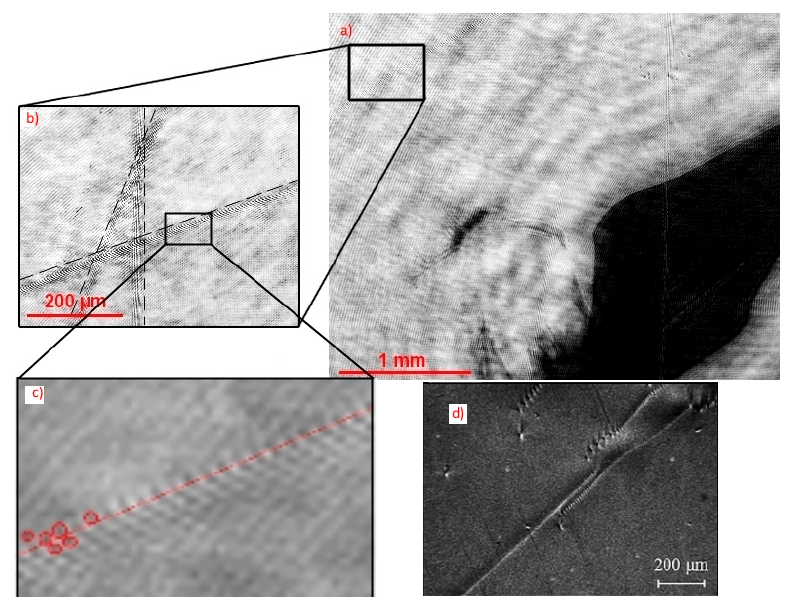
Figure 6. Hologram of the plate of unannealed material with thickness of 50 mm cut perpendicularly to the growth direction ( a ), holographic image restored from the chosen fragment of the hologram of the crystal plane located at a depth of 9 mm from the plate surface ( b ), zoomed image of a number of dislocations reconstructed from the restored image ( c ), and X-ray topogram of the cross section cut of the initial fragment of the single crystal ingot (result of investigations performed in [21] using X-ray transmission topography) ( d ).